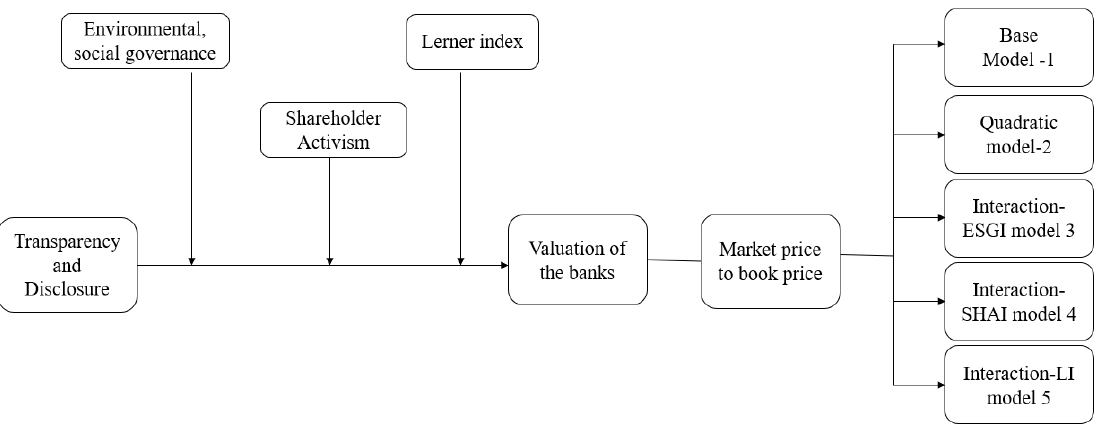
Figure 1. The conceptual model was adopted. Source: Authors compilation. Note: Strategy adopted for the study is portrayed in Figure 1.